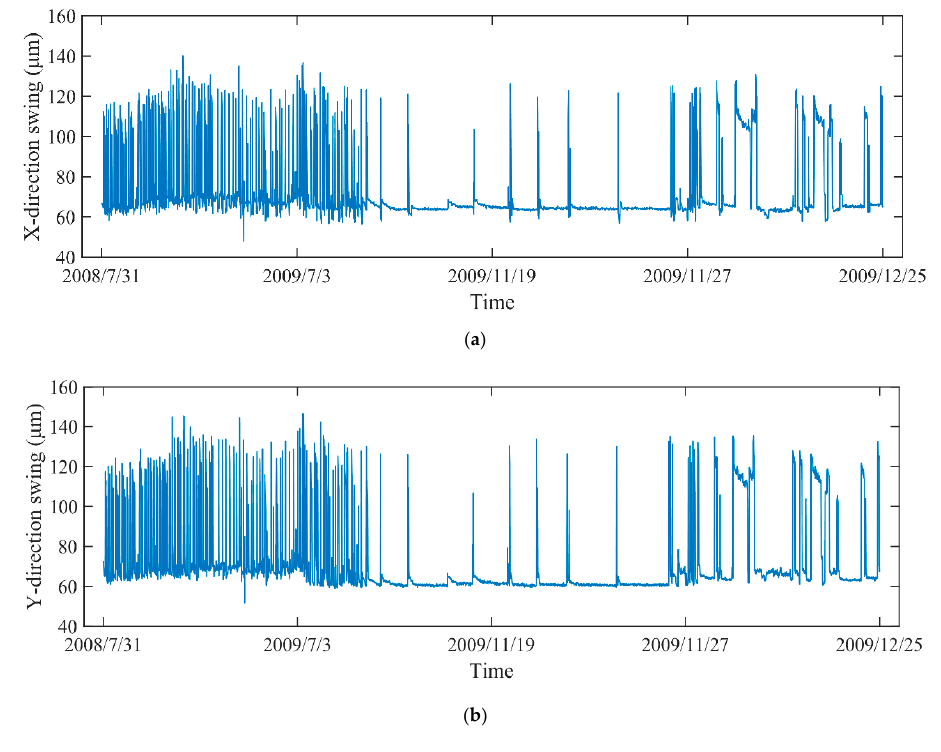
Figure 3. The monitoring data of PSU: ( a ) working head, ( b ) active power, ( c ) guide vane opening.